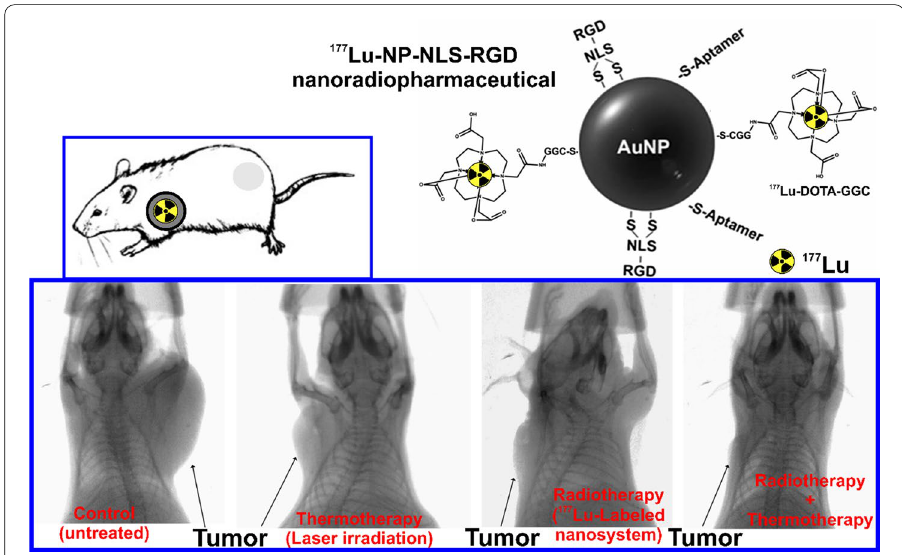
Fig. 4 Schematic representation of [ 177 Lu]Lu‑AuNPs‑NLS‑RGD‑Aptamer nano‑radiopharmaceutical. X‑ray images (X‑Treme/preclinical equipment) of mice with U87MG tumors under thermotherapy (AuNPs‑NLS‑RGD‑Aptamer under laser irradiation), targeted radiotherapy ([ 177 Lu] Lu‑AuNPs‑NLS‑RGD‑Aptamer), and thermotherapy plus radiotherapy ([ 177 Lu]Lu‑AuNPs‑NLS‑RGD‑Aptamer under laser irradiation) treatments at 96 h after the last injection (at 25 days of treatment) (González‑Ruíz et